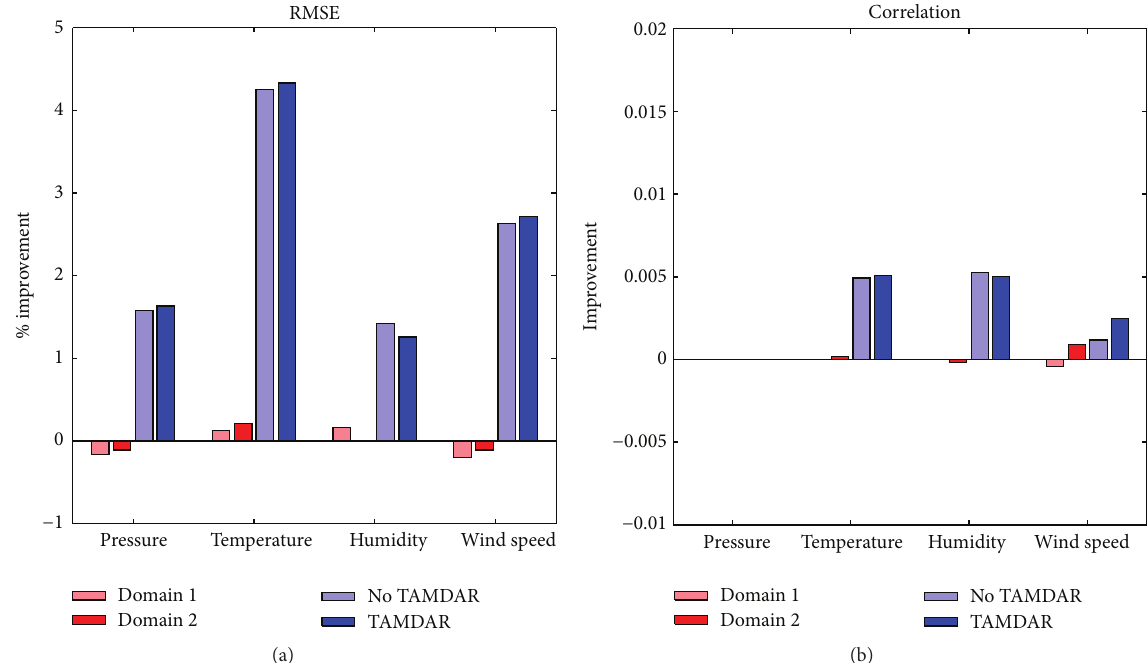
Figure 10: (a) Percentage improvements for root mean squared error (RMSE) and (b) correlation improvement for surface pressure, 2 m temperature, 2 m relative humidity, and 10m wind speed due to the assimilation of the TAMDAR data and the resolution increase. Red bars indicate improvements due to the TAMDAR data for each domain (Domain 1: light red; Domain 2: dark red) while blue bars indicate improvements due to using higher resolution (without TAMDAR data: light blue; with TAMDAR data: dark blue). The abscissa represents the variables while the ordinate represents the improvement. The statistics are averaged over all surface stations and the 6-day (August 1 through August 6) simulation